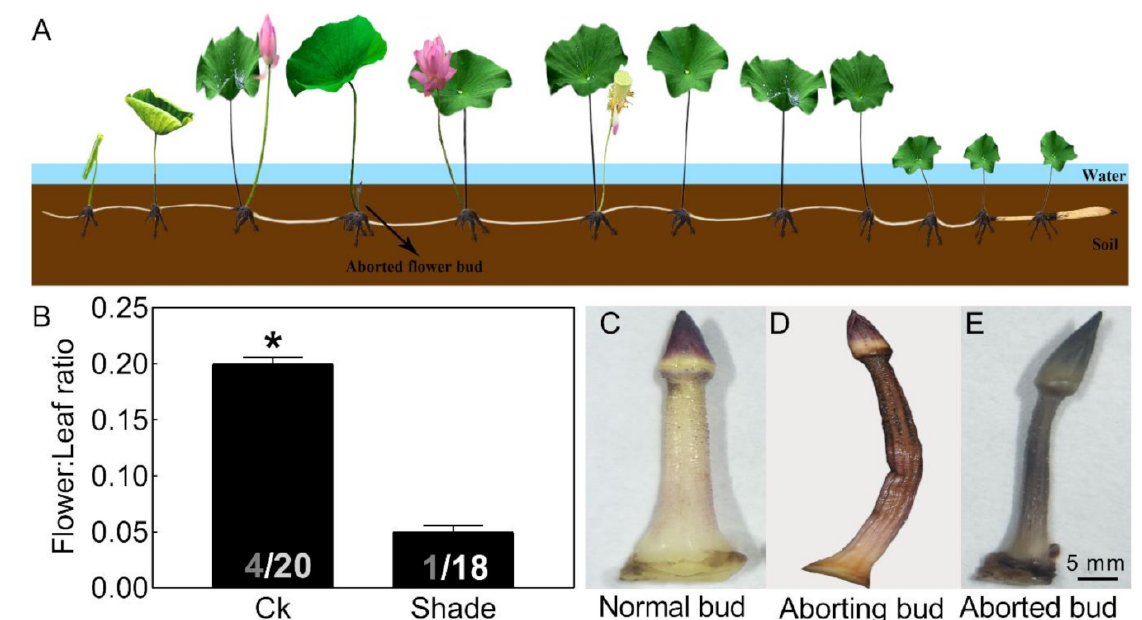
Figure 1. Phenotypic characteristics of lotus flower buds. Two-month old lotus seedlings were used in shading treatment and flower bud observation. ( A ) Schematic representation of lotus growth. ( B ) Flower:leaf ratio of a lotus with or without 50% shading treatment for 6 weeks. The numbers on the bottom of each column represent the corresponding number of flowers and leaves of flower:leaf ratio. ( C – E ) Photographs of normal ( C ), aborting ( D ), and aborted lotus flower buds ( E ). Values are the means ± SE of three independent experiments with at least three replicates for each. Bars with asterisks were significantly different in comparison with Ck (no treated) at * p < 0.05, according to t